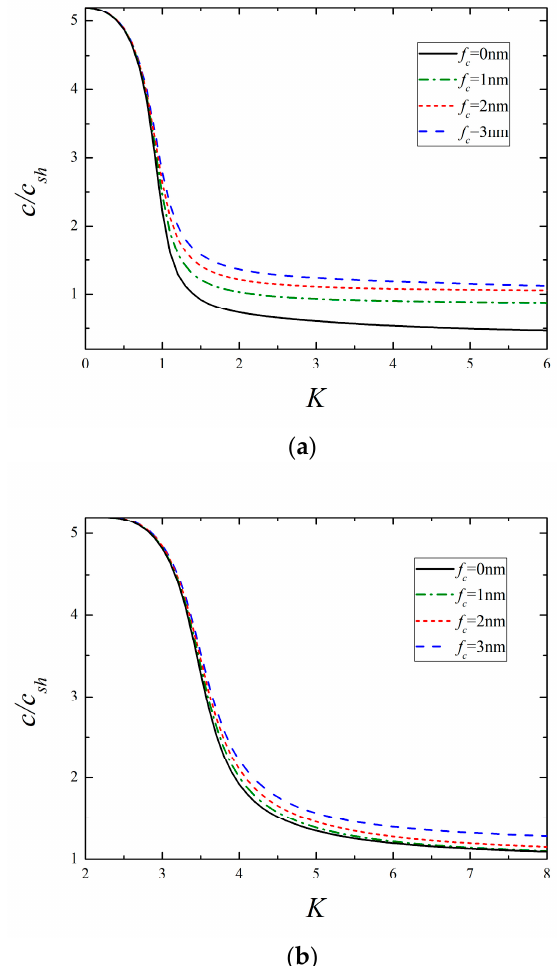
Figure 4. The lowest two modes for different surface elasticity ( f e = 0.5 nm, f κ = f ρ = 1 nm). ( a ) The 1st mode and ( b ) the 2nd mode.